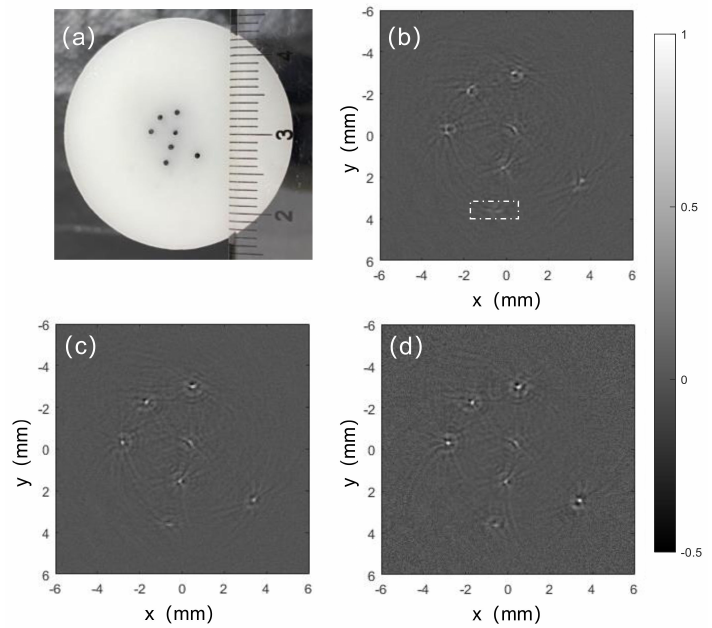
Figure 6. Experiment results for imaging point targets with different reconstruction algorithms. ( a ) Photo of the phantom; ( b ) the conventional BP algorithm; ( c ) the TDC-BP algorithm; ( d ) The proposed SIR-BP algorithm. The amplitude of ( b – d ) are all normalized to 1.